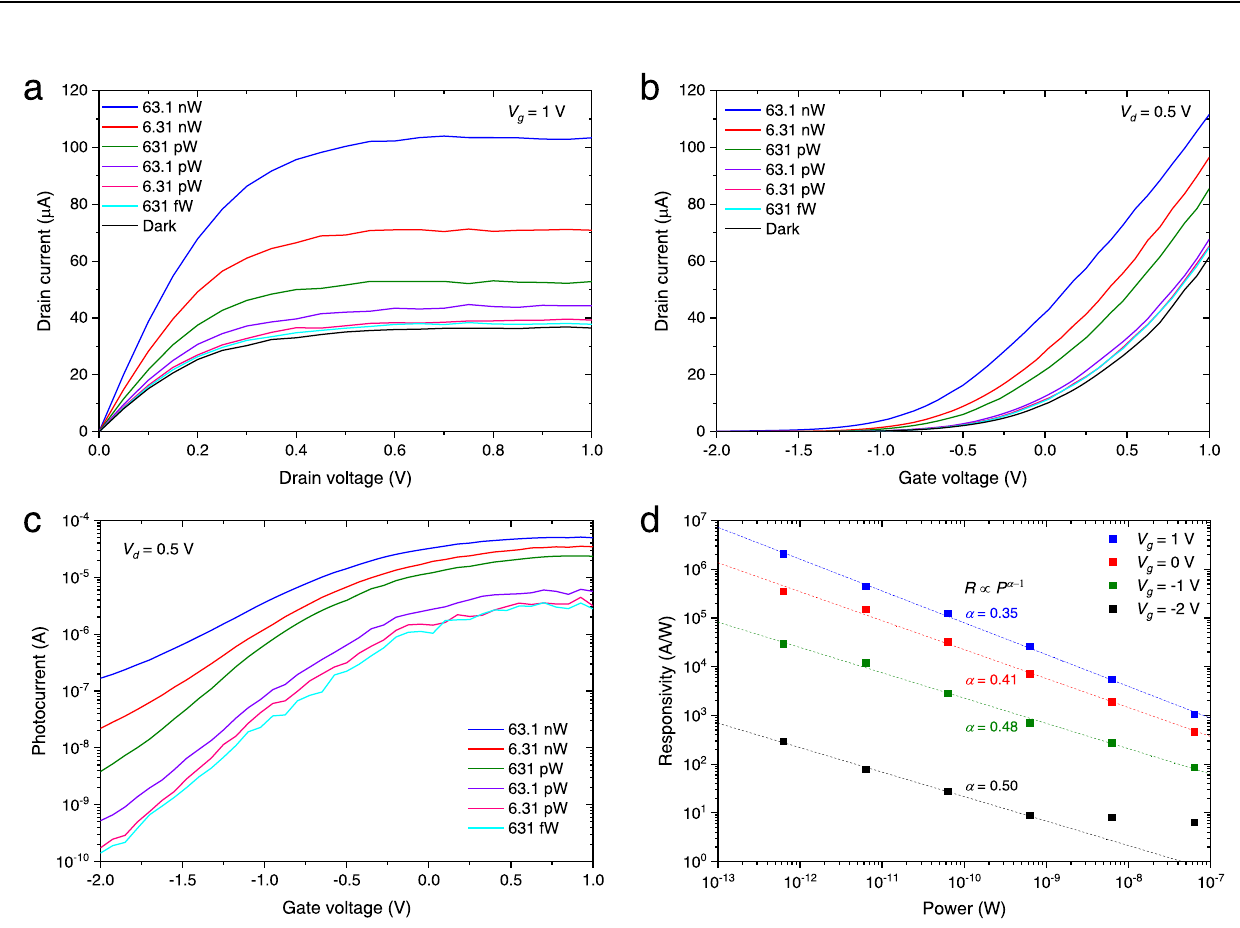
Fig. 3 | Photoresponses of a waveguide-coupled InGaAs phototransistor with light injection of a 1.3 μ m wavelength. a I d – V d characteristics with V g of 1V. b I d – V g characteristics in the linear scale with V d of 0.5V. c Photocurrent as a